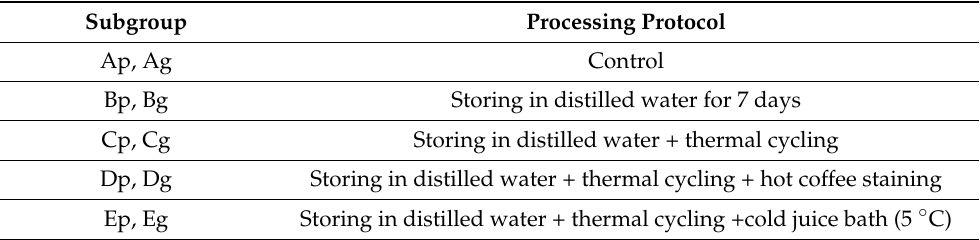
Table 2. Protocols according to each